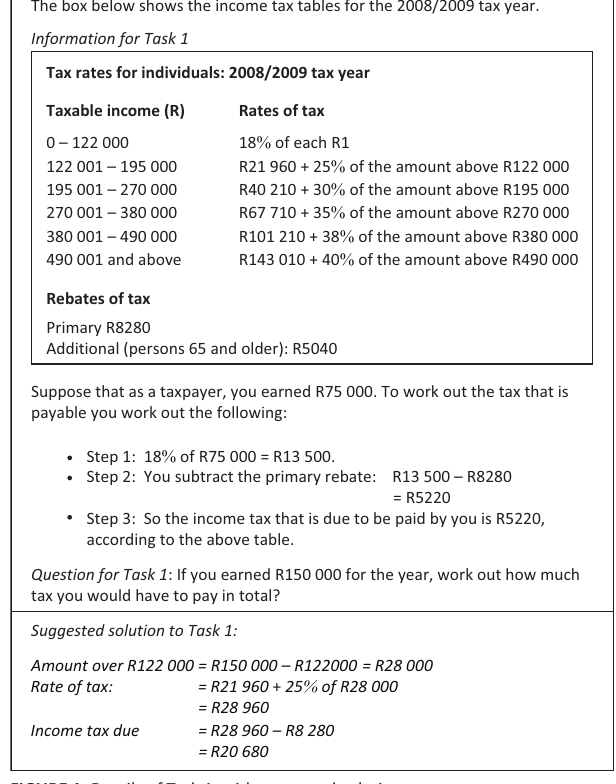
FIGURE 1: Details of Task 1, with suggested solution.